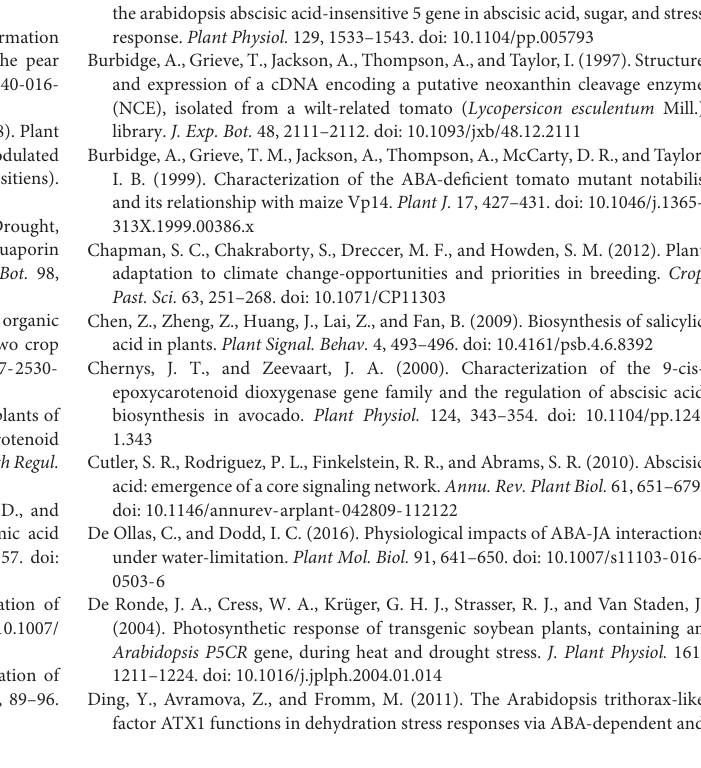
FIGURE S1 | Amino acid sequence alignment of the deduced amino acids of ZSYNCED with NCED from Vitis vinifera ‘Pinot Noir’ PNNCED1 (VV78X205727.5). Black color denotes the homologous regions. FIGURE S2 | Regenerated putative transgenic grapevine plants in normal (A) and malformed plants (B) . Arrows indicate malformed cotyledon and